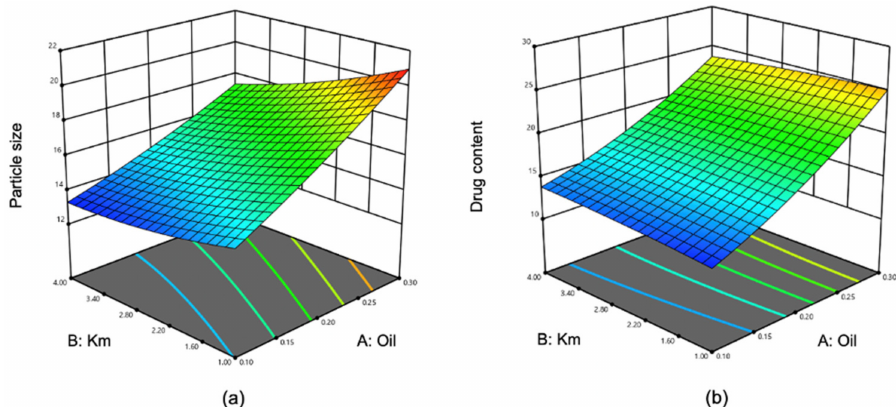
Figure 4. Three-dimensional response surface charts exhibiting the effects of independent variables